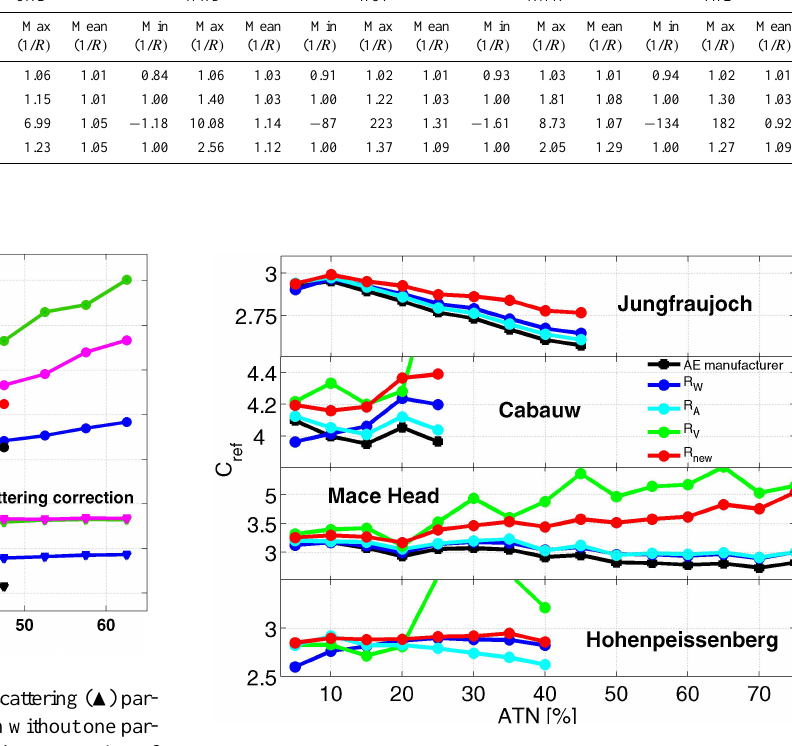
Fig. 4. C ref calculated from b abs corresponding to a defined ATN as a function of ATN for the four filter-loading corrections and for the JFJ, CAB, MHD and HOP datasets as well as for the b abs AE output calculated as recommended by the manufacturer. For JFJ and CAB, b abs at λ =660nm are represented. For JFJ, the Virkkula filter- loading correction leads to too high C ref values varying between 3.7 and 17, and for HOP, the AE b abs calculated as recommended by the manufacturer leads to around 0.6; these extreme values are not shown for clarity